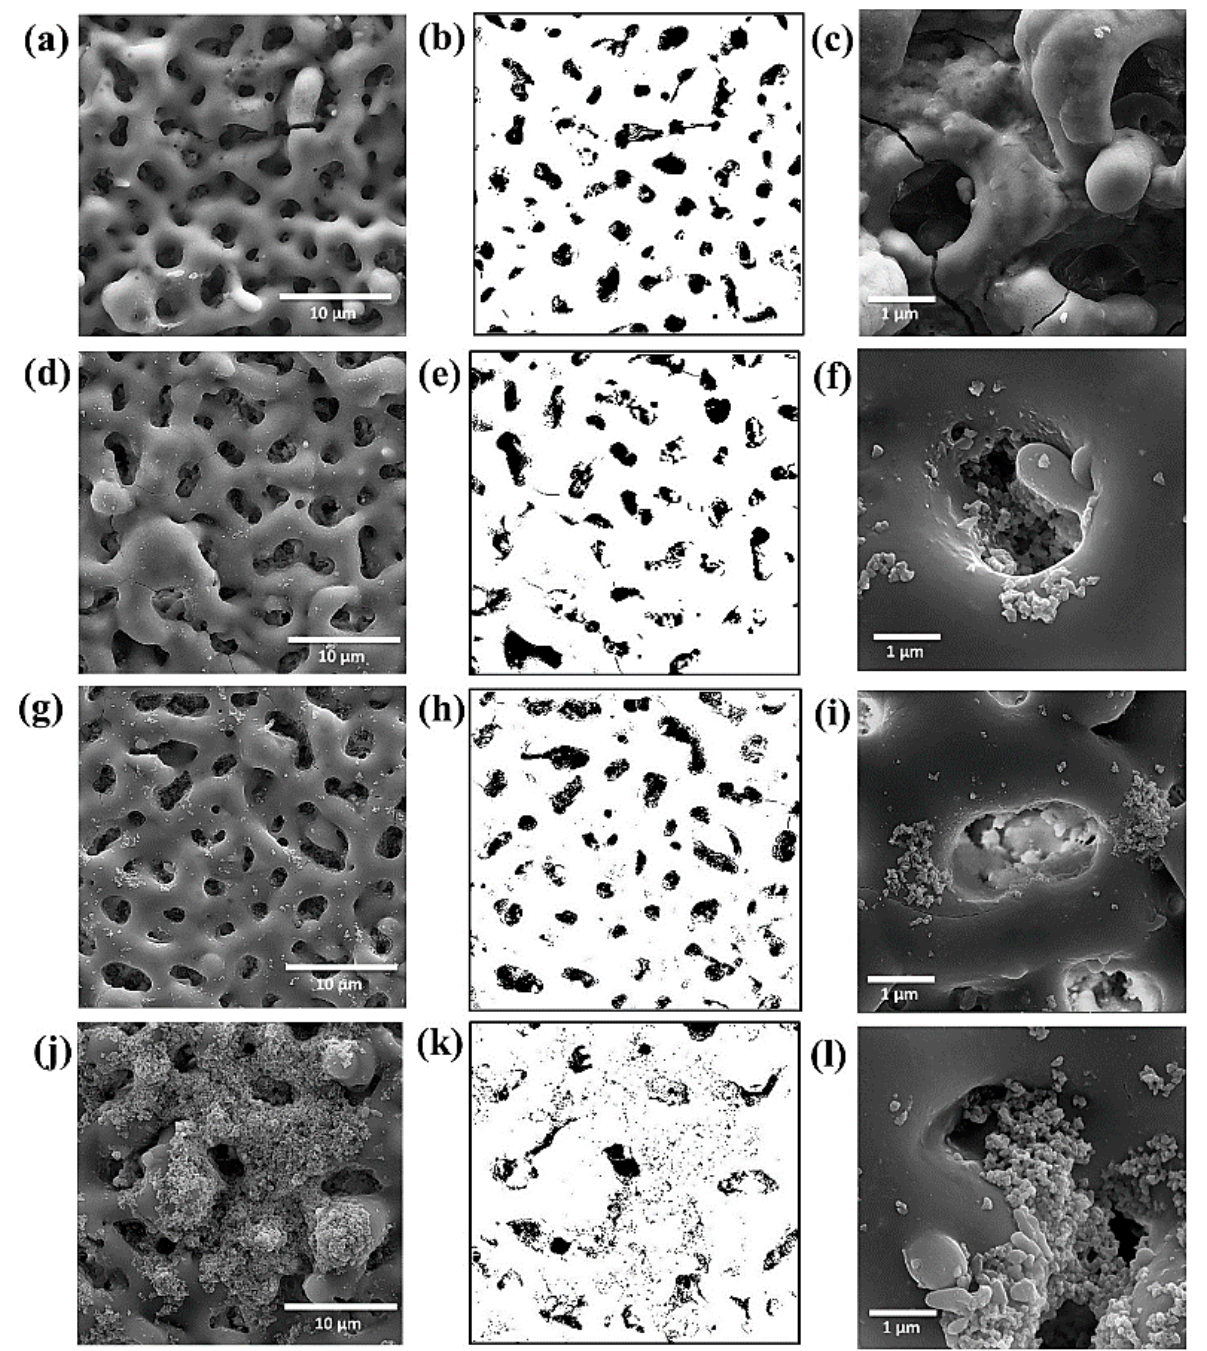
Figure 15. FE-SEM surface morphology for samples Z0 ( a – c ), Z1 ( d – f ), Z2 ( g – i ) and Z3 ( j – l ). Reproduced with permission from [130]. Copyright Elsevier,